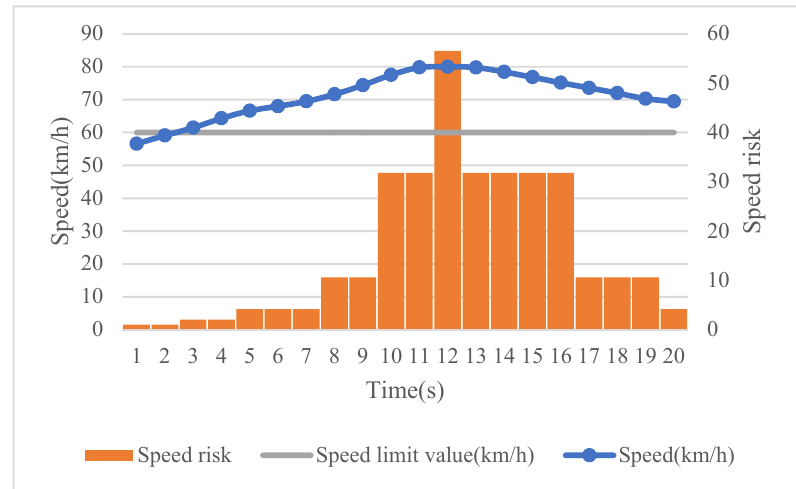
Figure 5. The absolute risk of speeding—the area method.